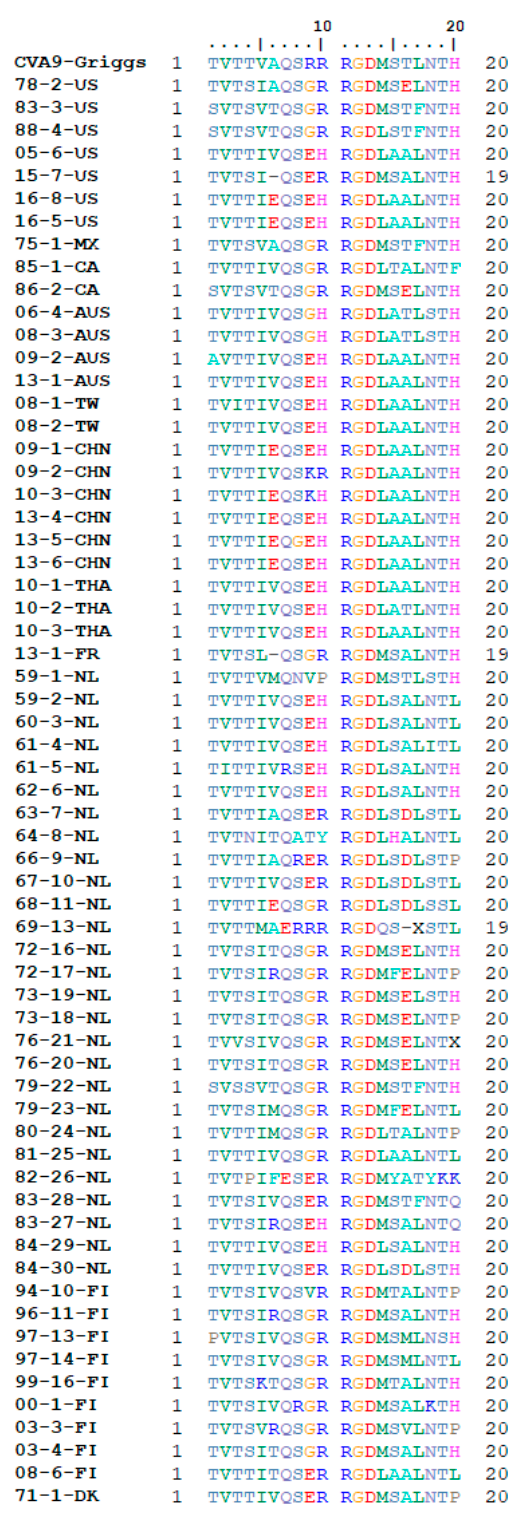
Figure 2. CVA9 RGD binding site analysis showing fully conserved nature of the RGD motif in all of the analyzed isolates. VP1 position 290 in the prototype strain Griggs is equivalent to position 11 in the alignment.